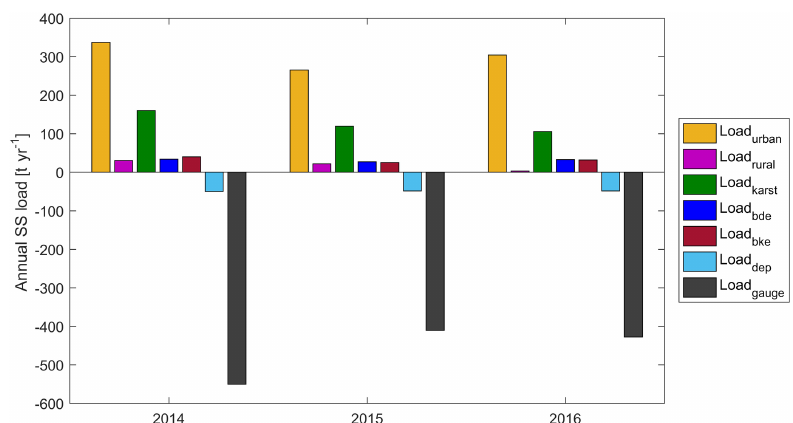
Figure 6. Annual suspended sediment loads from different processes. Load gauge is calculated by modeled discharge and suspended sedi- ment concentrations at catchment outlet. Load urban , Load rural , and Load karst are calculated using the results of sediment-generating model. Load dep , Load bde , and Load bke are the sum of deposition load, suspended sediments eroded from river bed and river bank of the entire river network for a whole year, respectively. In this figure, the positive values represent sediment input to the river channel, while negative values denote sediment output from the river channel.